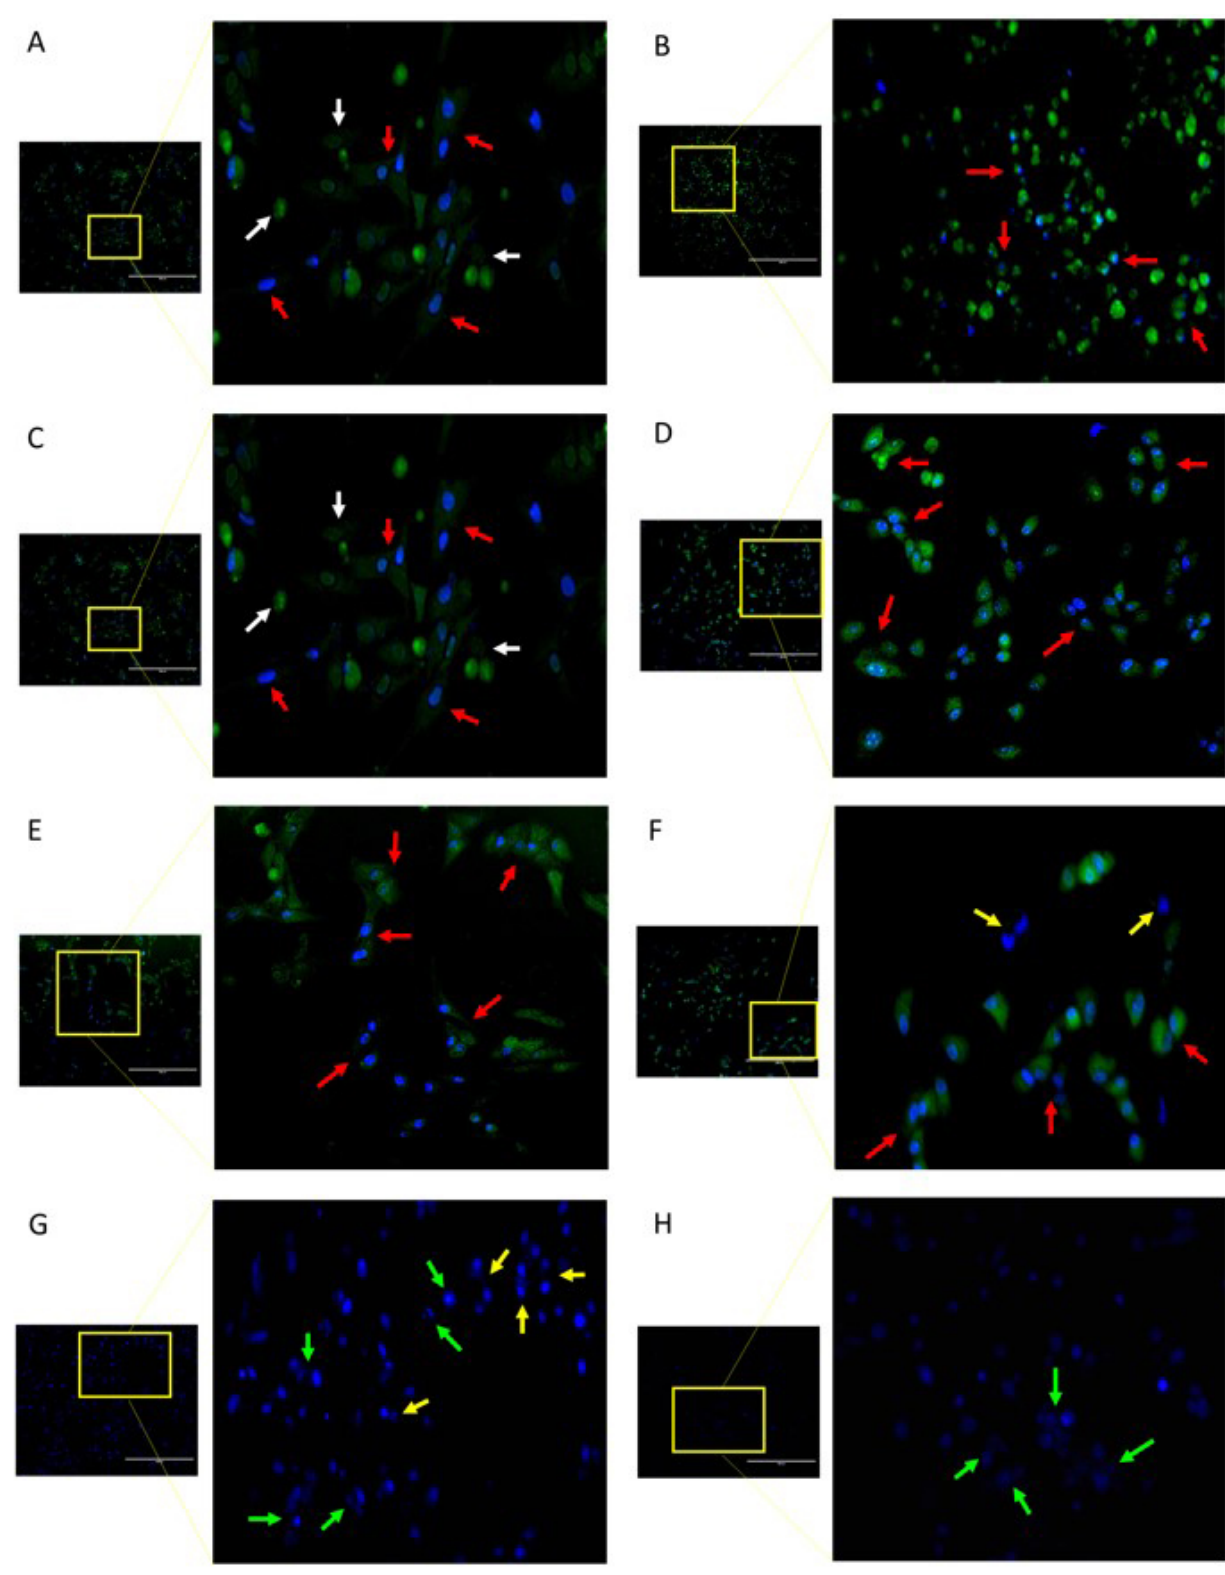
Figure 4. Photographs of A549 cells at 48 hours post-treatment with 200 µg/mL concentration of (A) crude spider venom, (B) cisplatin, and different spider venom fractions: (C) AT5-1, (D) AT5-2, (E) AT5-3, (F) AT5-4, (G) AT5-5, and (H) AT5-6. Arrow indicates different cytological features of A549 cells: red = apoptotic cells; white = apoptotic bodies; yellow = mitotic cells; green = compromised nuclear membrane. Magnification: 40x; scale bars represent 40